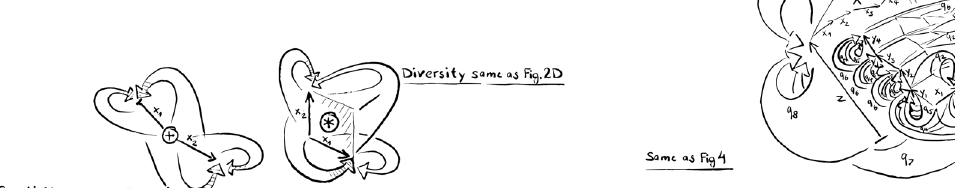
with many dimensions that interact.